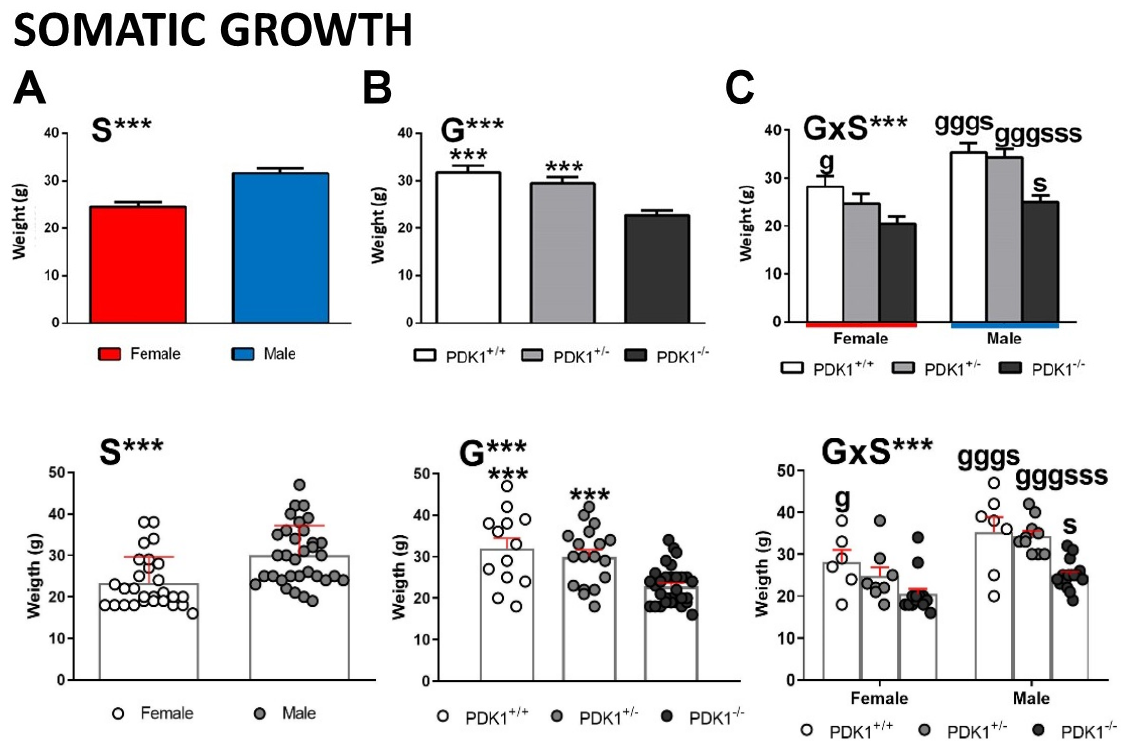
Figure 2. Somatic growth/ body weight in female and male mature PDK1 − / − , heterozygous PDK1 +/ − and homozygous WT (PDK1 +/+ ) mice. Top panel: Data are expressed as mean ± SEM. Bottom panel: Individual data are depicted. Bars illustrate the genotype or sex groups. Factorial analysis: ( A ) S, sex effect; ( B ) G, genotype effect; ( C ) G × S, genotype × sex interaction effects; *** p < 0.001. Post-hoc test: genotype: g p < 0.05, ggg p < 0.01 vs. the corresponding KO (PDK1 − / − , black bar) group; s (sex), s p < 0.05, sss p < 0.001 vs. the corresponding male of the same genotype.